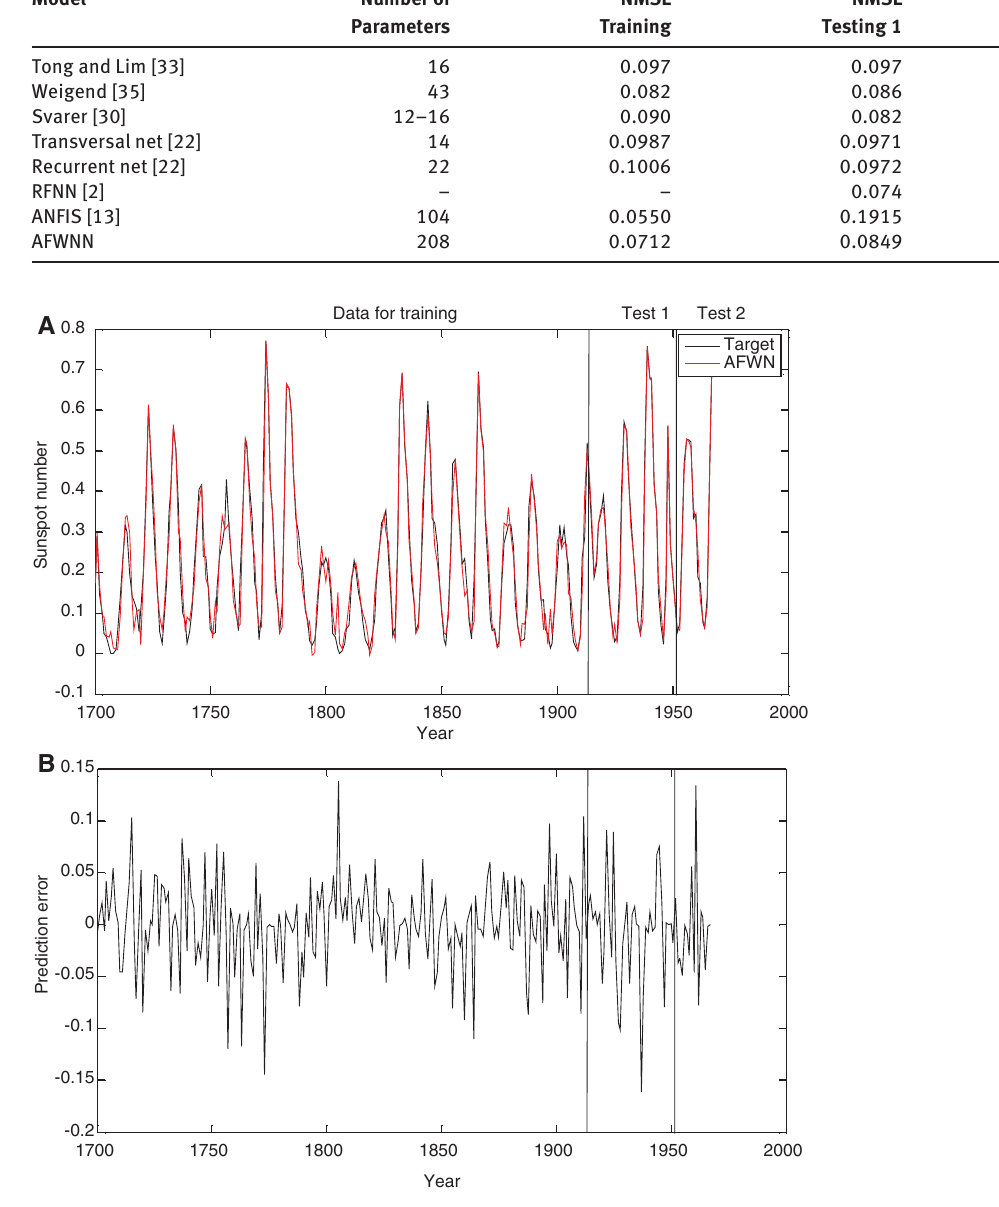
Figure 3. AFWNN Model Results for Sunspot Time Series. (A) Actual and prediction values. (B) Prediction